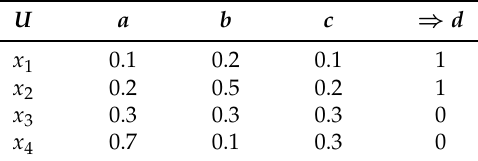
Table 1. A classification